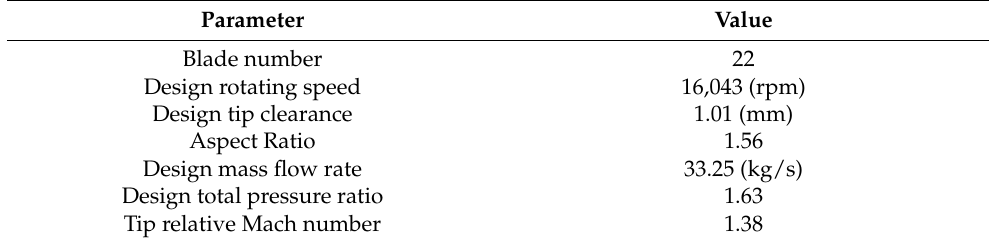
Table 1. Geometric parameters of the Rotor67